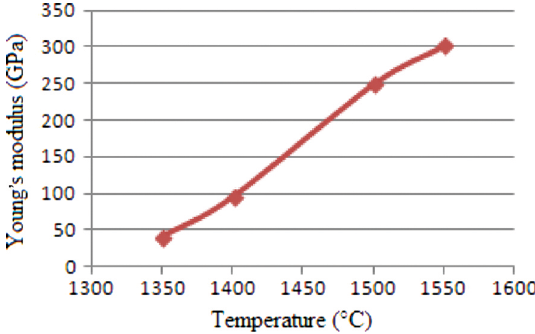
Figure 2: Variation of Young ’ s modulus as a function of